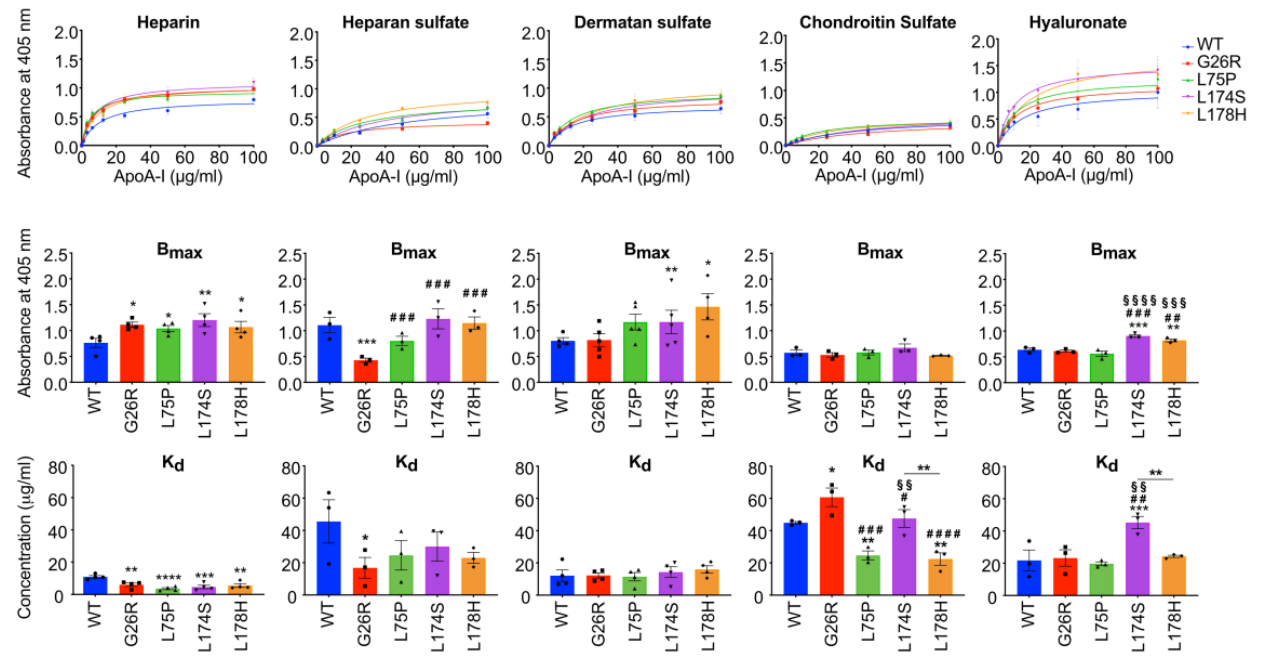
Figure 4. ApoA-I amyloidogenic variants’ differential binding to ECM components. 96-well plates were coated with 25 μg /mL of each ECM component under test and probed with ApoA-I amyloidogenic variants at increasing concentrations. The ability of variants to bind ECM components was quantified as a function of protein concentration (upper panels). The experimental data were fitted and B max (middle panels) and K d (lower panels) were calculated according to the Michaelis-Menten equation. Data shown are the means ± SEM of 3 to 5 independent experiments carried out in duplicate. Significance is calculated according to one-way ANOVA (* p < 0.05, ** p < 0.005, *** p < 0.001, **** p < 0.0001 for groups as shown with respect to the WT protein, # p < 0.05, ## p < 0.005, ### p < 0.001, #### p < 0.0001 for groups as shown with respect to G26R variant, § p < 0.05, §§ p < 0.005, §§§ p < 0.001, §§§§ p < 0.0001 for groups as shown with respect to L75P variant).